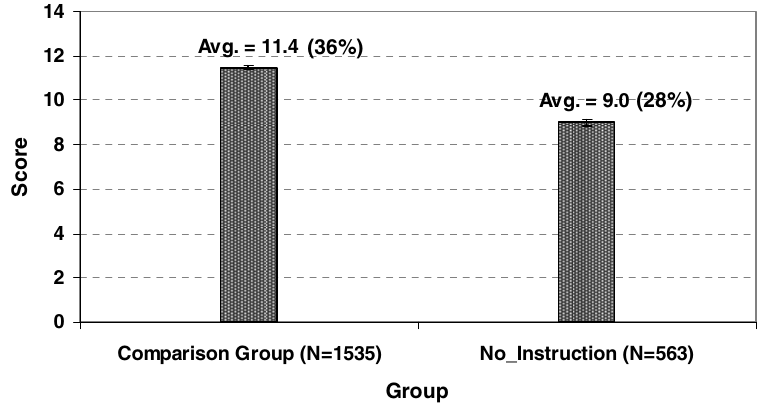
FIG. 2. Pre-test total scores of the comparison group and the no-instruction group. (cid:1) The percent- ages indicate average pre-test score percentages; the error bars denote standard errors. (cid:2)